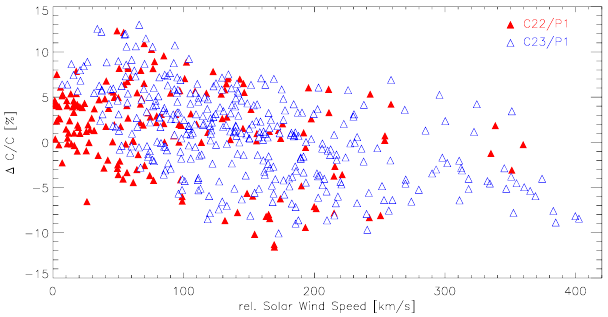
Fig. 5. Daily averages of the relative galactic cosmic ray variation as a function of the reduced solar wind speed for cycles C22/P1 (red) and C23/P1